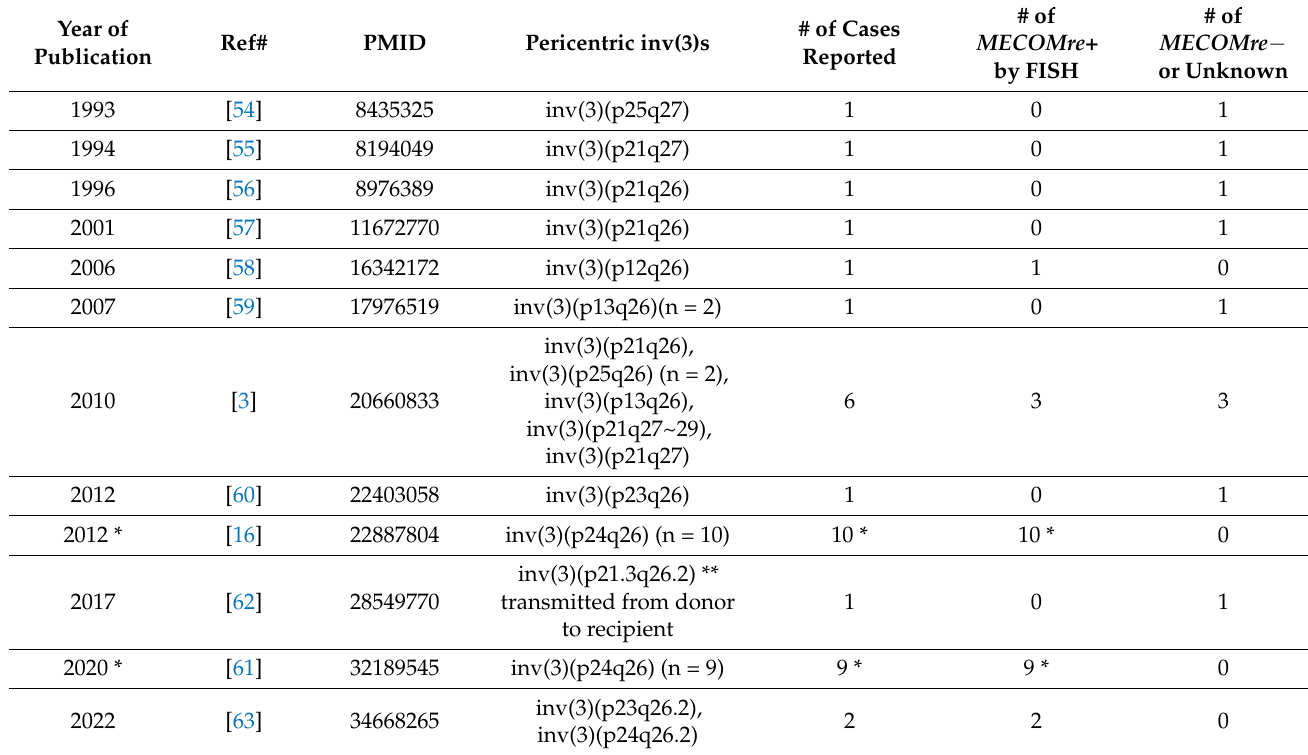
Table 4. A summary of cases with pericentric inv(3)s reported in the